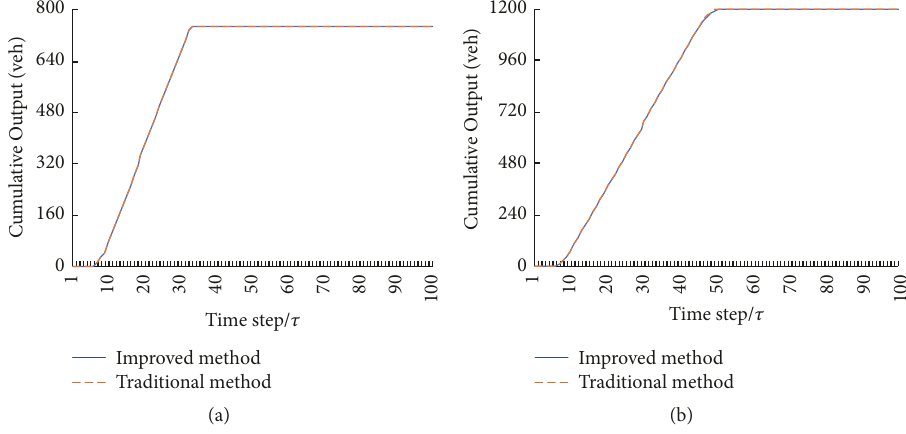
Figure 6: Cumulative evacuees arriving at the shelter: (a) low demand; (b) high demand.